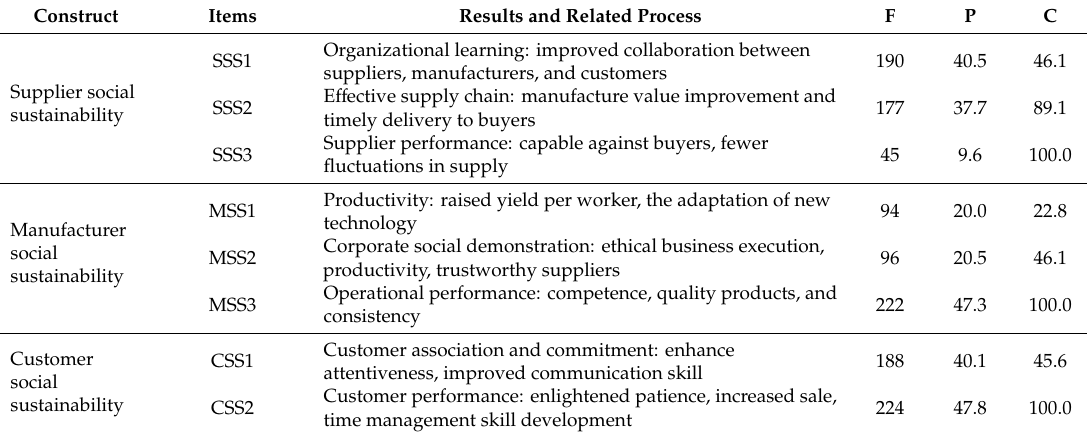
Table 6. Dimension wise results and processes (supplier, manufacturer, and